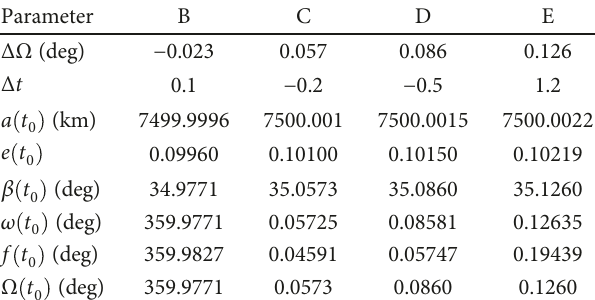
Figure 7: Case Table 1: All near circular orbital elements.